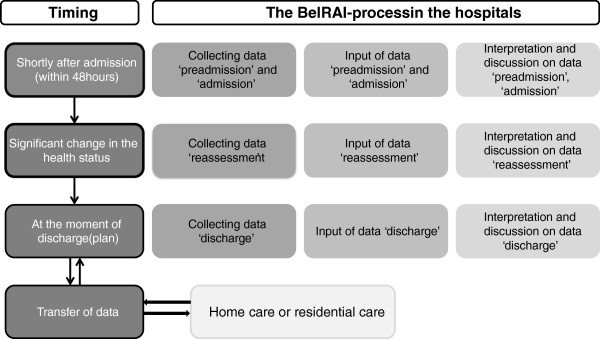
The BelRAI-process.